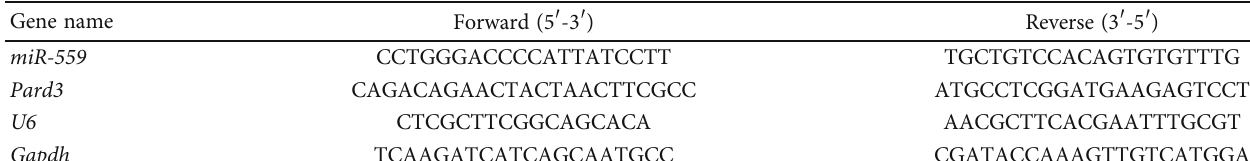
Table 1: The information of primers.